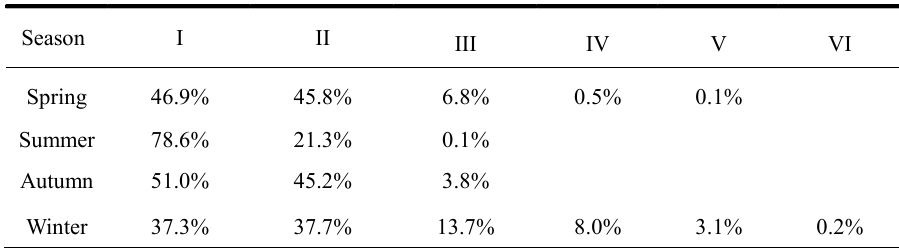
concentration in Guilin city in 2.5